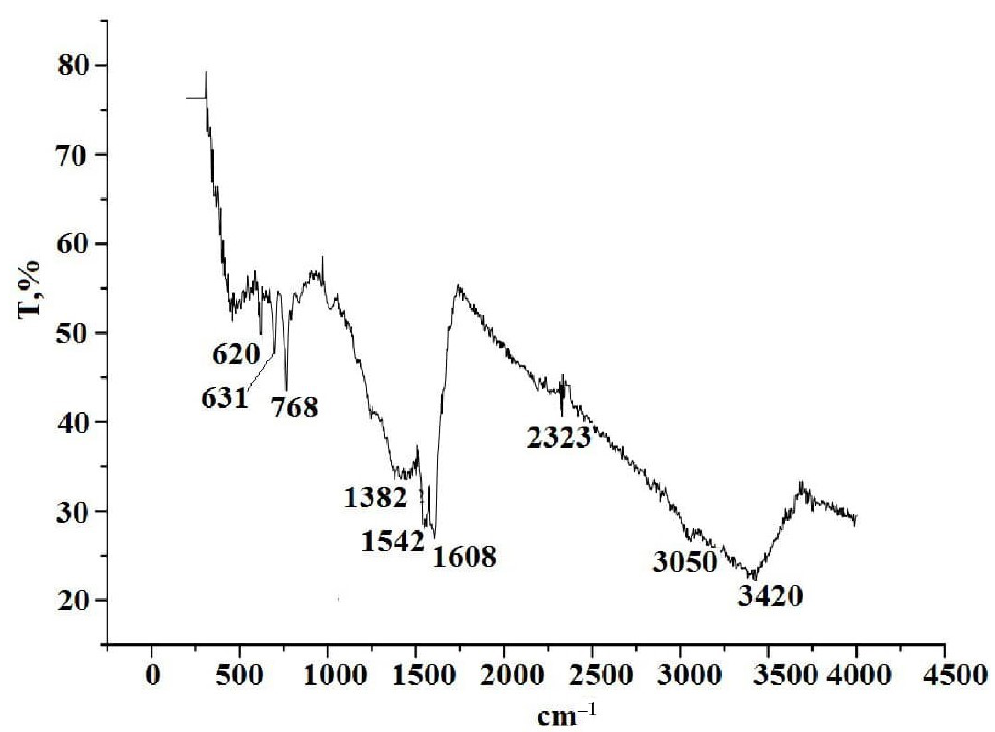
Figure 13. IR spectrum of the thermolysis product of silver maleate in xylene.